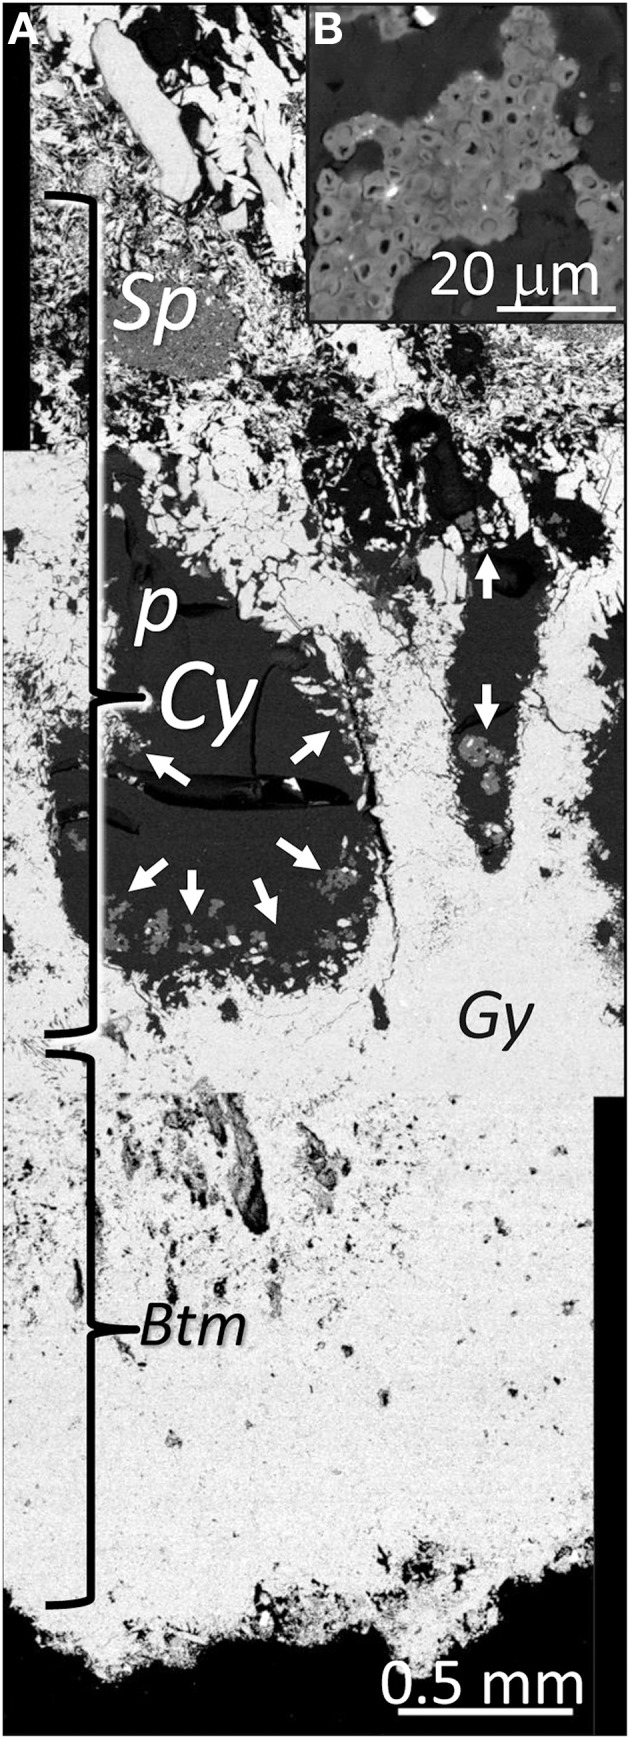
(A) SEM-BSE image of the bottom part of the gypcrete colonized by hypoendolithic cyanobacteria (Cy) forming aggregates; pore, p; sepiolite nodule, Sp; arrows point to cyanobacteria aggregates; hypoendolithic cyanobacteria colonization zone, Cy; bottom layer, Btm; gypsum, Gy. (B) Details of cyanobacteria aggregate.